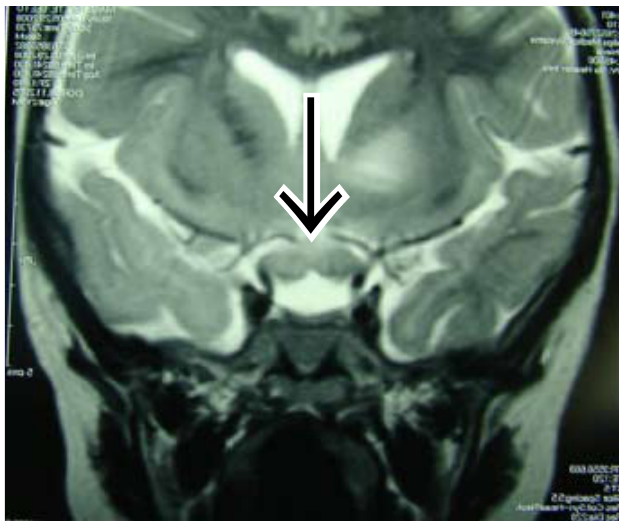
Fig. 3c. Coronal T2-weighted MRI demonstrates chiasmatic glioma in a patient with NF1. High signal is also visualised in the left basal